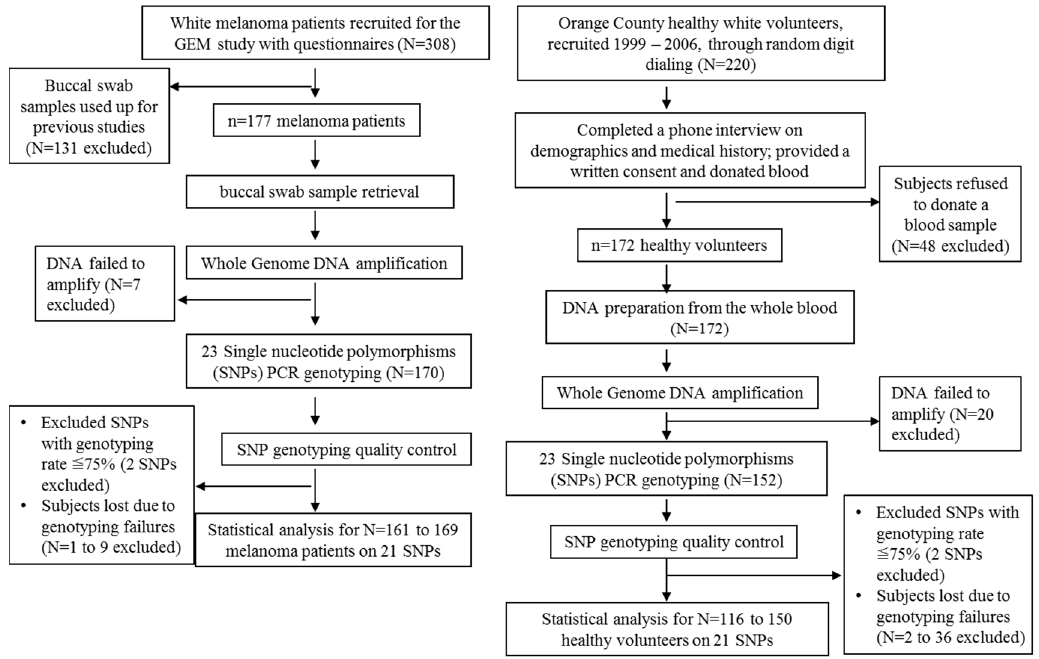
Figure 2. The inclusion and exclusion criteria of the participants in this study.